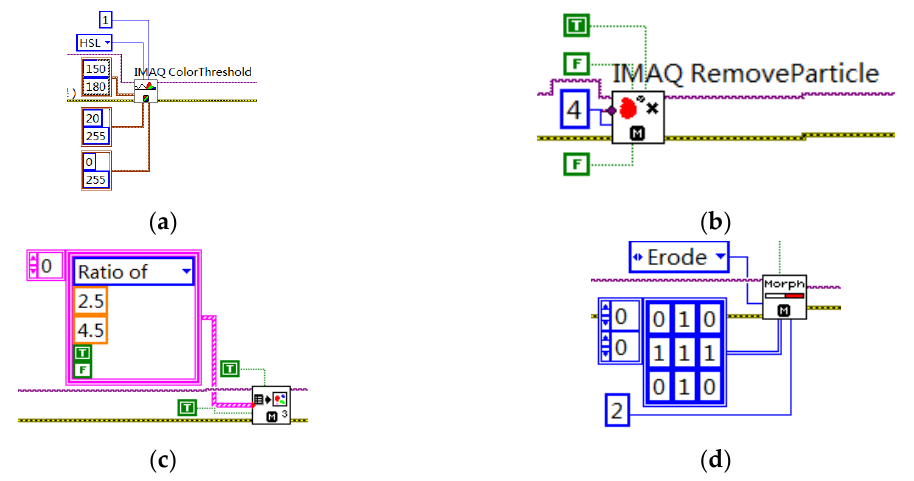
Figure 16. Program block diagram: ( a ) binarization, ( b ) denoising, ( c ) particle filter, and ( d ) corrosion operation.